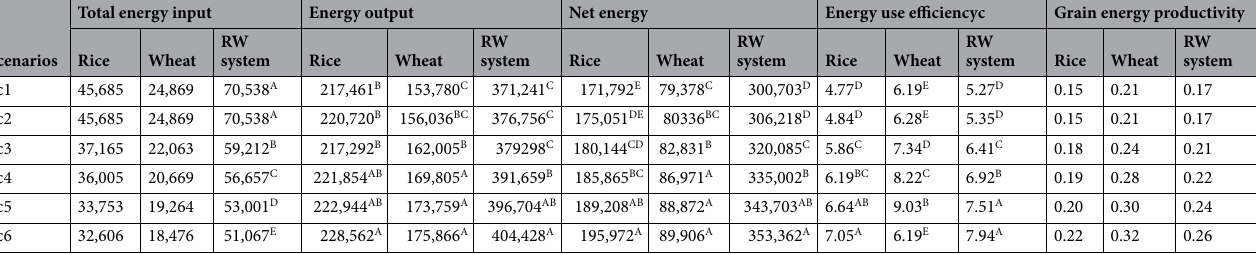
Table 3. Energy (MJ ha −1 ) balance under different management practices in rice, wheat and RW system (mean of 3 years). Values with different upper case (A–E) letters are significantly different between each scenarios at p < 0.05 (Duncan multiple range tests for separation of mean). Sc1, business as usual-conventional tillage (CT) without residue; Sc2, CT with residue; Sc3, reduce tillage (RT) with residue + recommended dose of fertilizer (RDF); Sc4, RT/Zero tillage (ZT) with residue + RDF; Sc5, ZT with residue + RDF + GreenSeeker + Tensiometer; Sc6, Sc5 + Nutrient